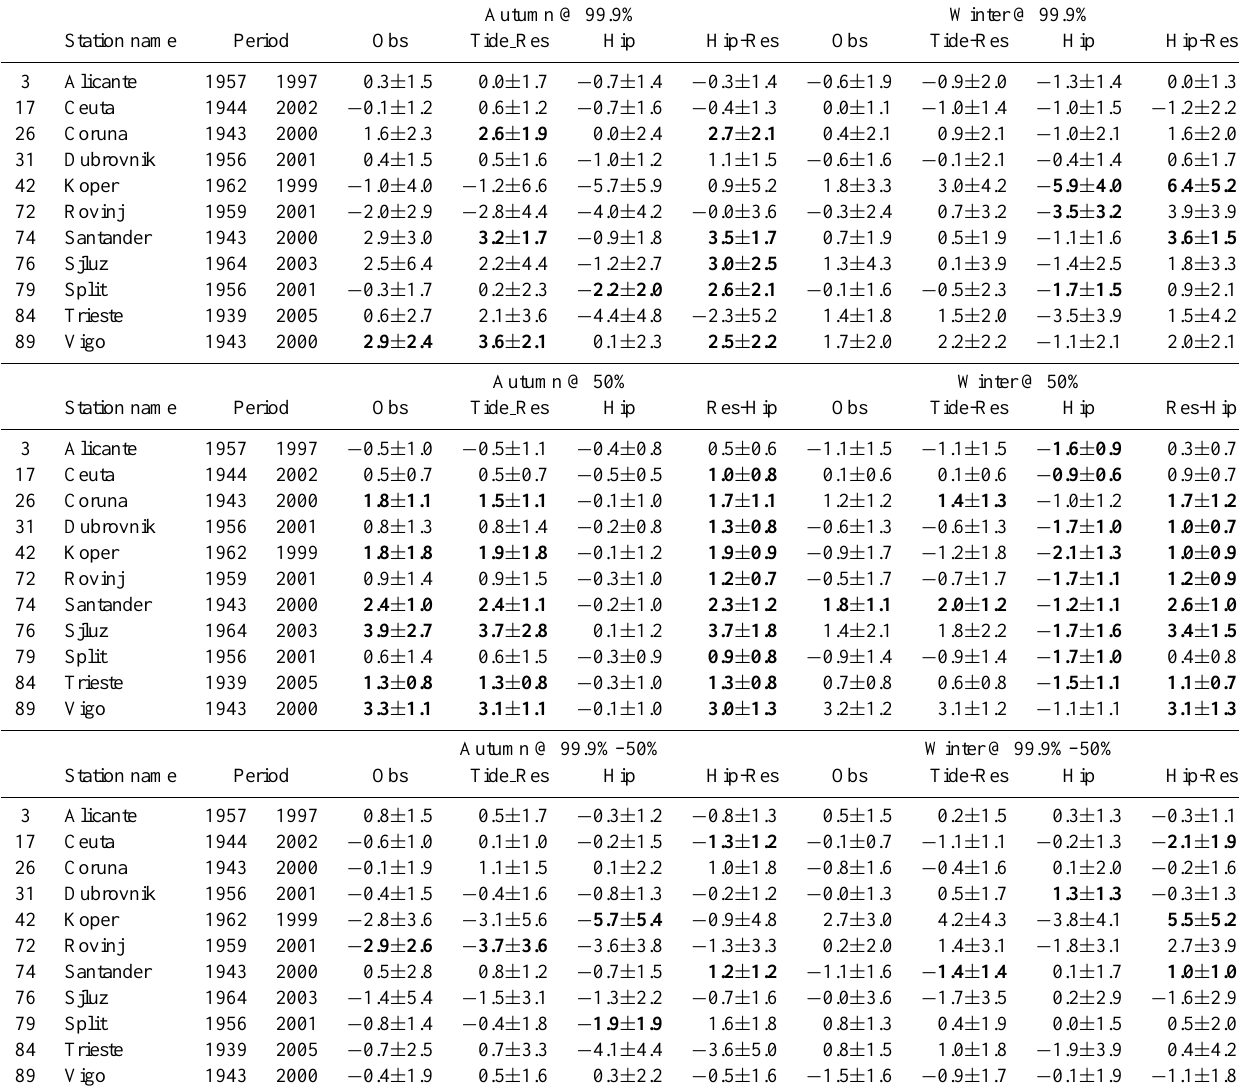
Table 2. Seasonal trends for the 99.9 percentile, the 50 percentile and the 99.9–50 percentile in mm/yr. There are four columns for each season that correspond to the trend estimated from tide gauge observations, tidal residuals, the model values (HIPOCAS) and the tide residuals minus HIPOCAS, respectively. Note, that because HIPOCAS covers the period 1958 and 2001, the trend estimates at the fourth column of each season only covers the overlapping period between HIPOCAS data and the corresponding tide-gauge record. The error bars are those of the linear fit at the 95% level of